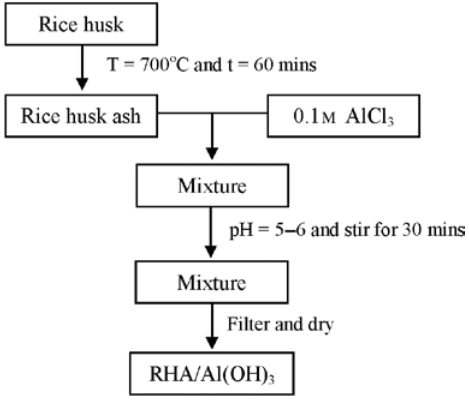
from rice husk 3